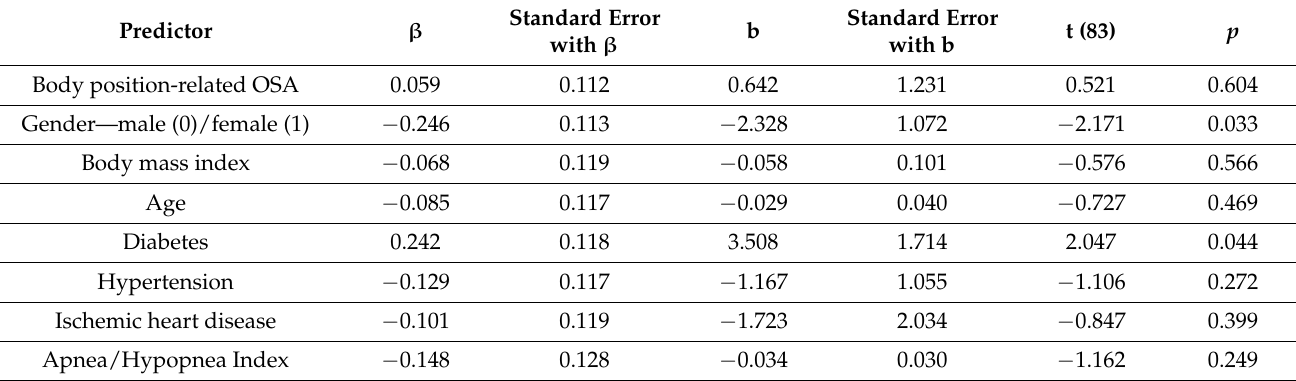
Table 4. Multiple regression analysis for independent predictors of higher BEI